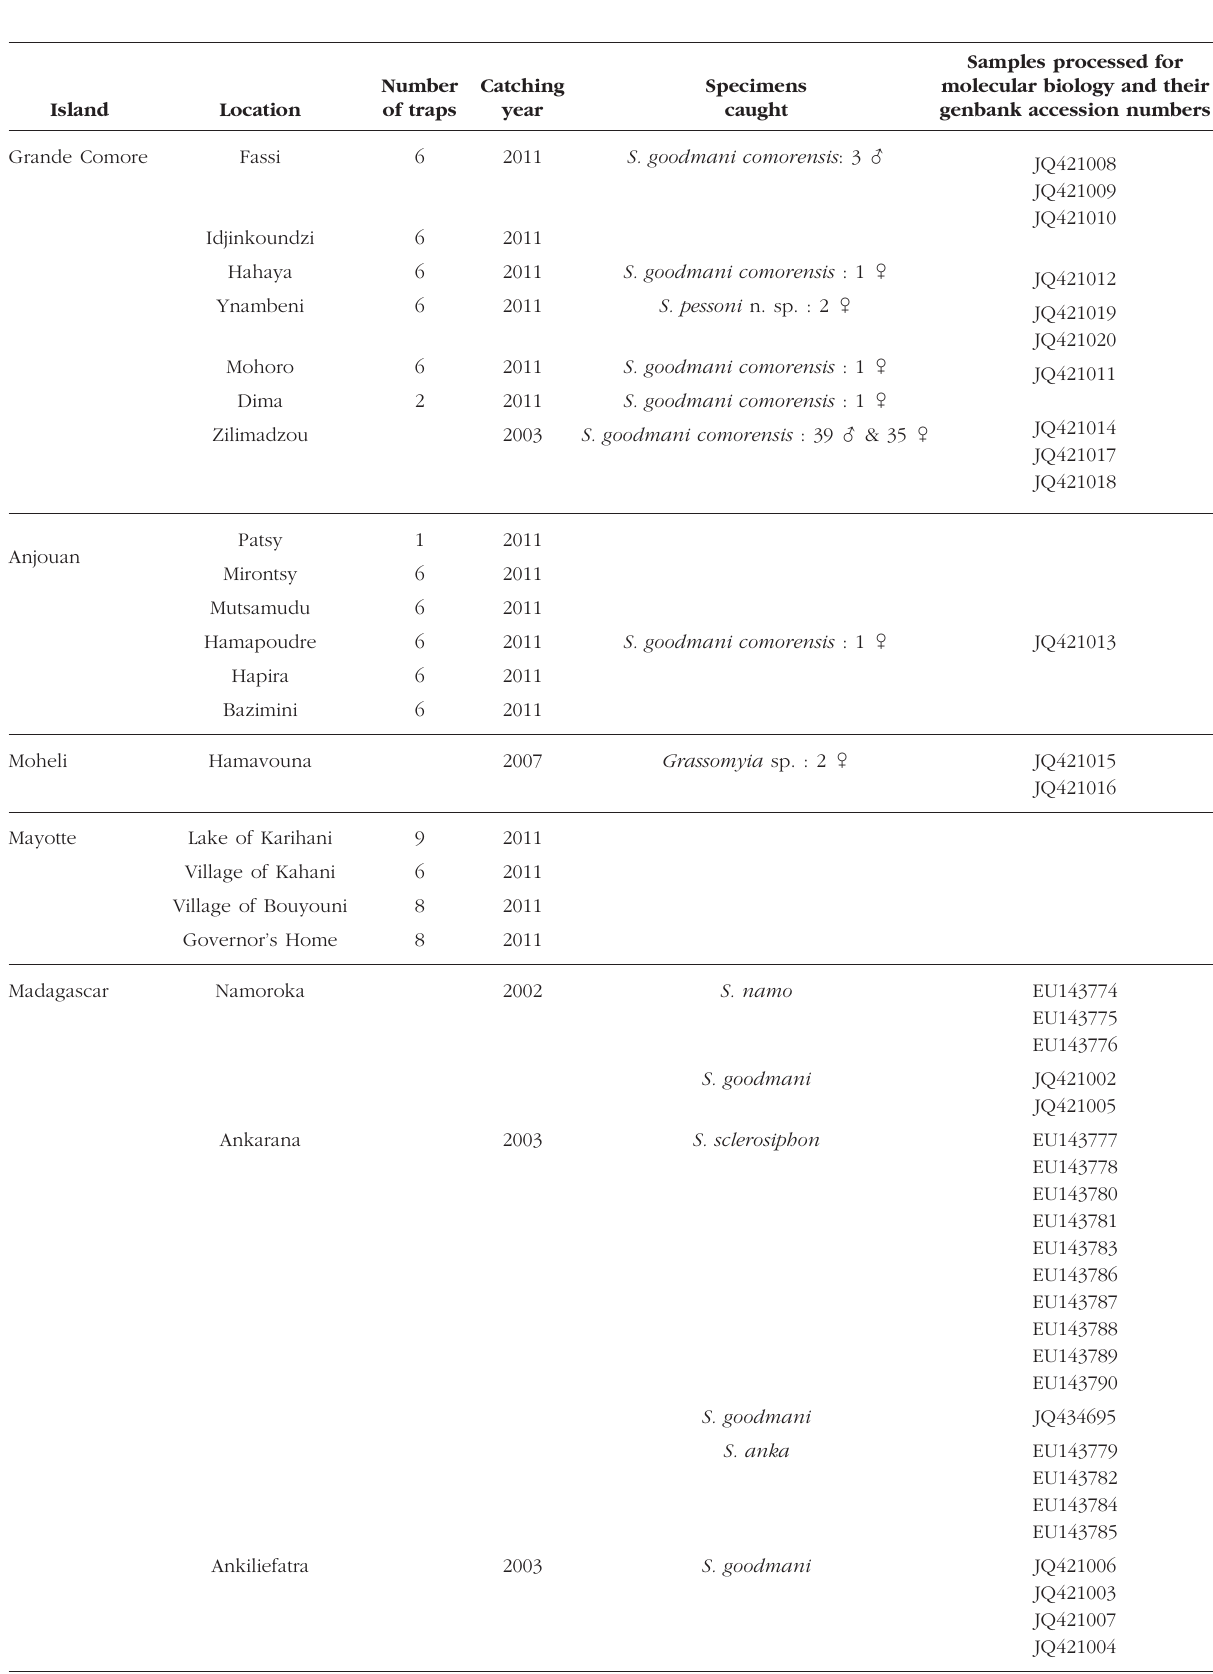
Table I. – Sampling